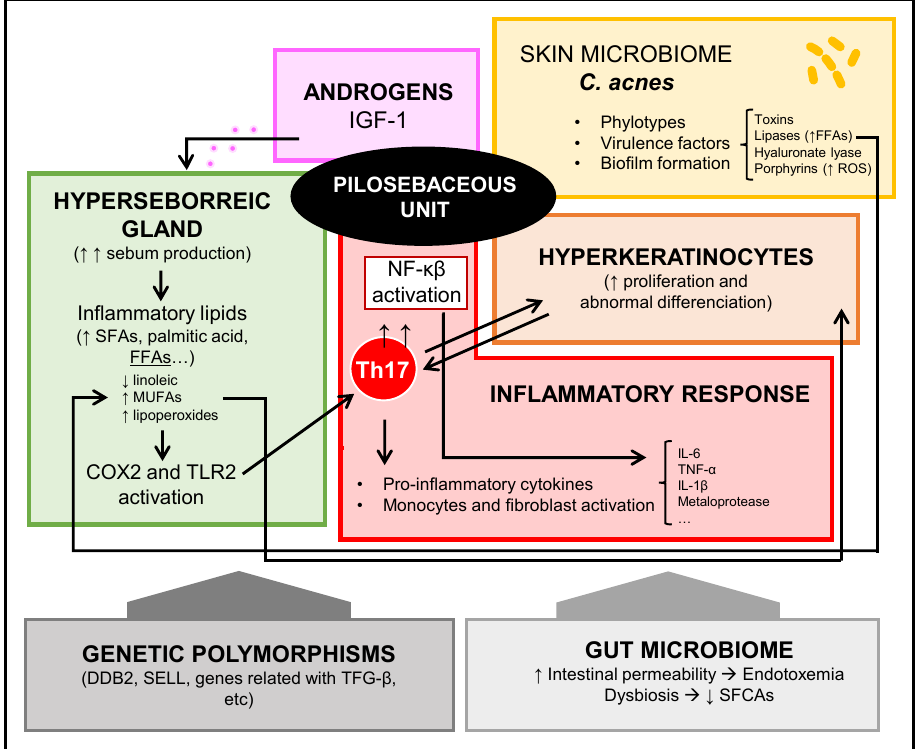
Figure 2. Pathogenic mechanisms of acne. IGF-1: insulin-like growth factor 1, FFAs: free fatty acids, ROS: reactive oxygen species, SFAs: saturated fatty acids, MUFAs: monounsaturated fatty acids, COX2: cyclooxygenase 2, TLR2: Toll-like receptor 2, Th17: Th17 cells, NF- κ B: nuclear factor-kappa B, TGF- β : transforming growth factor receptor β , SCFAs: short-chain fatty acids.